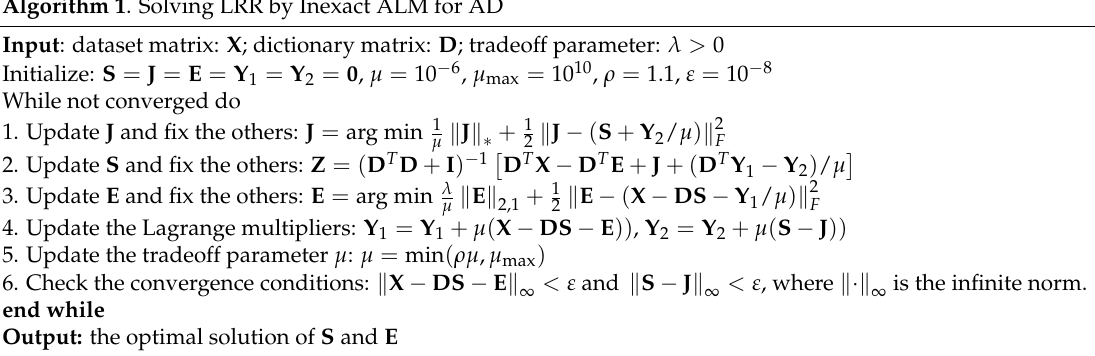
Algorithm 1 . Solving LRR by Inexact ALM for